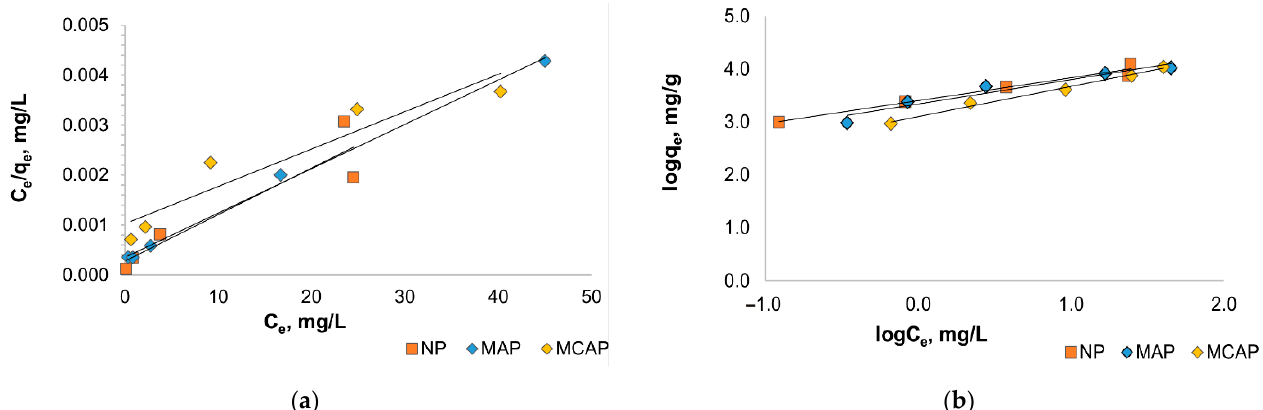
Figure 9. Langmuir ( a ) and Freundlich ( b ) isotherms of Cu 2+ sorption on natural peat (NP), mechanically activated peat (MAP), mechanochemically activated peat (MCAP).